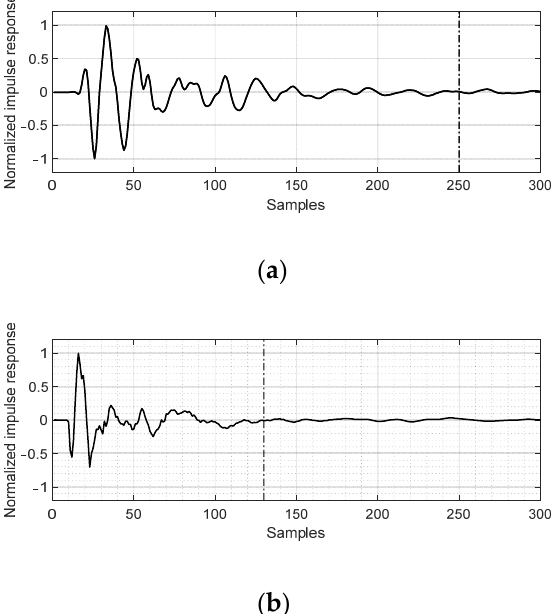
Figure 6. Comparison of the normalized impulse responses of the measured secondary paths when the ESG– cowl pair ( a ) or a typical built-in door loudspeaker ( b ) is